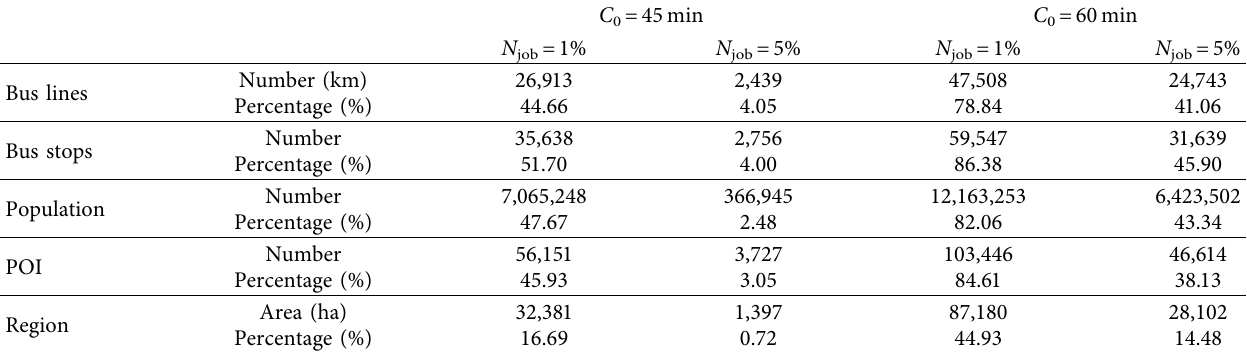
Table 2: Social resources within the region between the boundary and urban